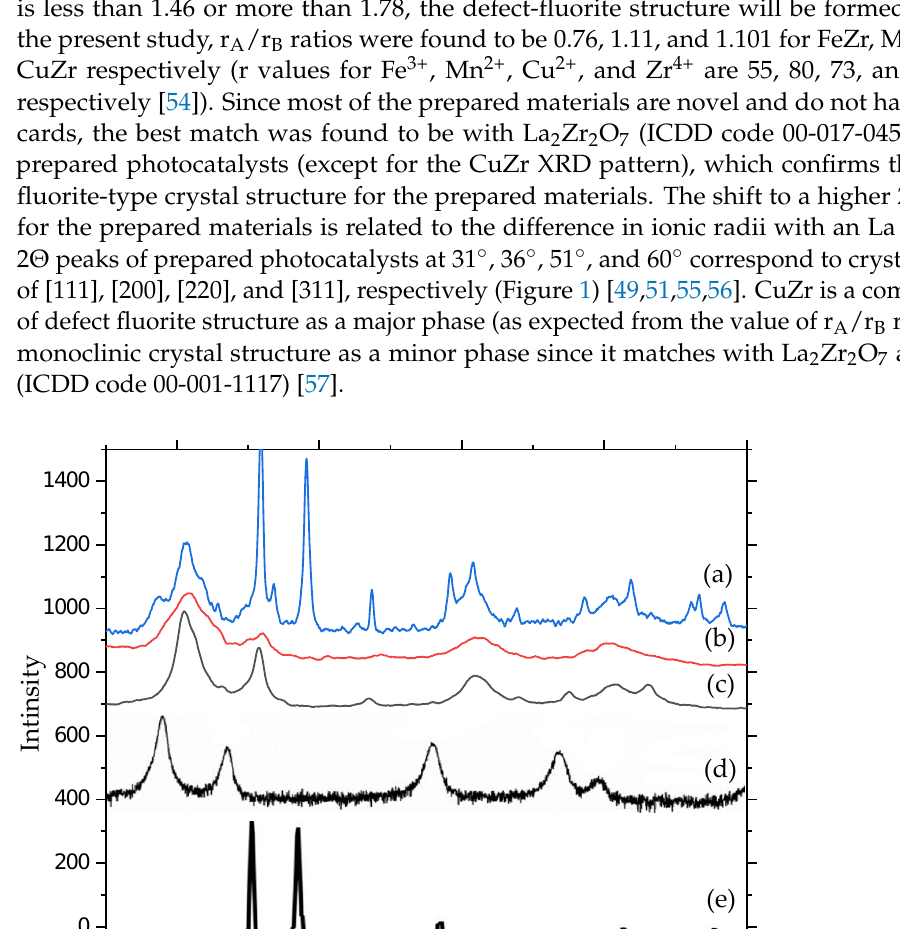
Figure 2. Powder x-ray pattern for the prepared doped systems. The measured average particle size of the prepared photocatalysts shown in Table 2 indicates that doping Fe with Mn or Cu increases particle size, but doping Zr by W de- creases particle size. Additionally, increasing the dopant concentration increases the par- ticle size due to the higher dopant size [49,58]. Table 2. Average particle size of the prepared nano photocatalysts. Photocatalyst Average Particle Size (nm)